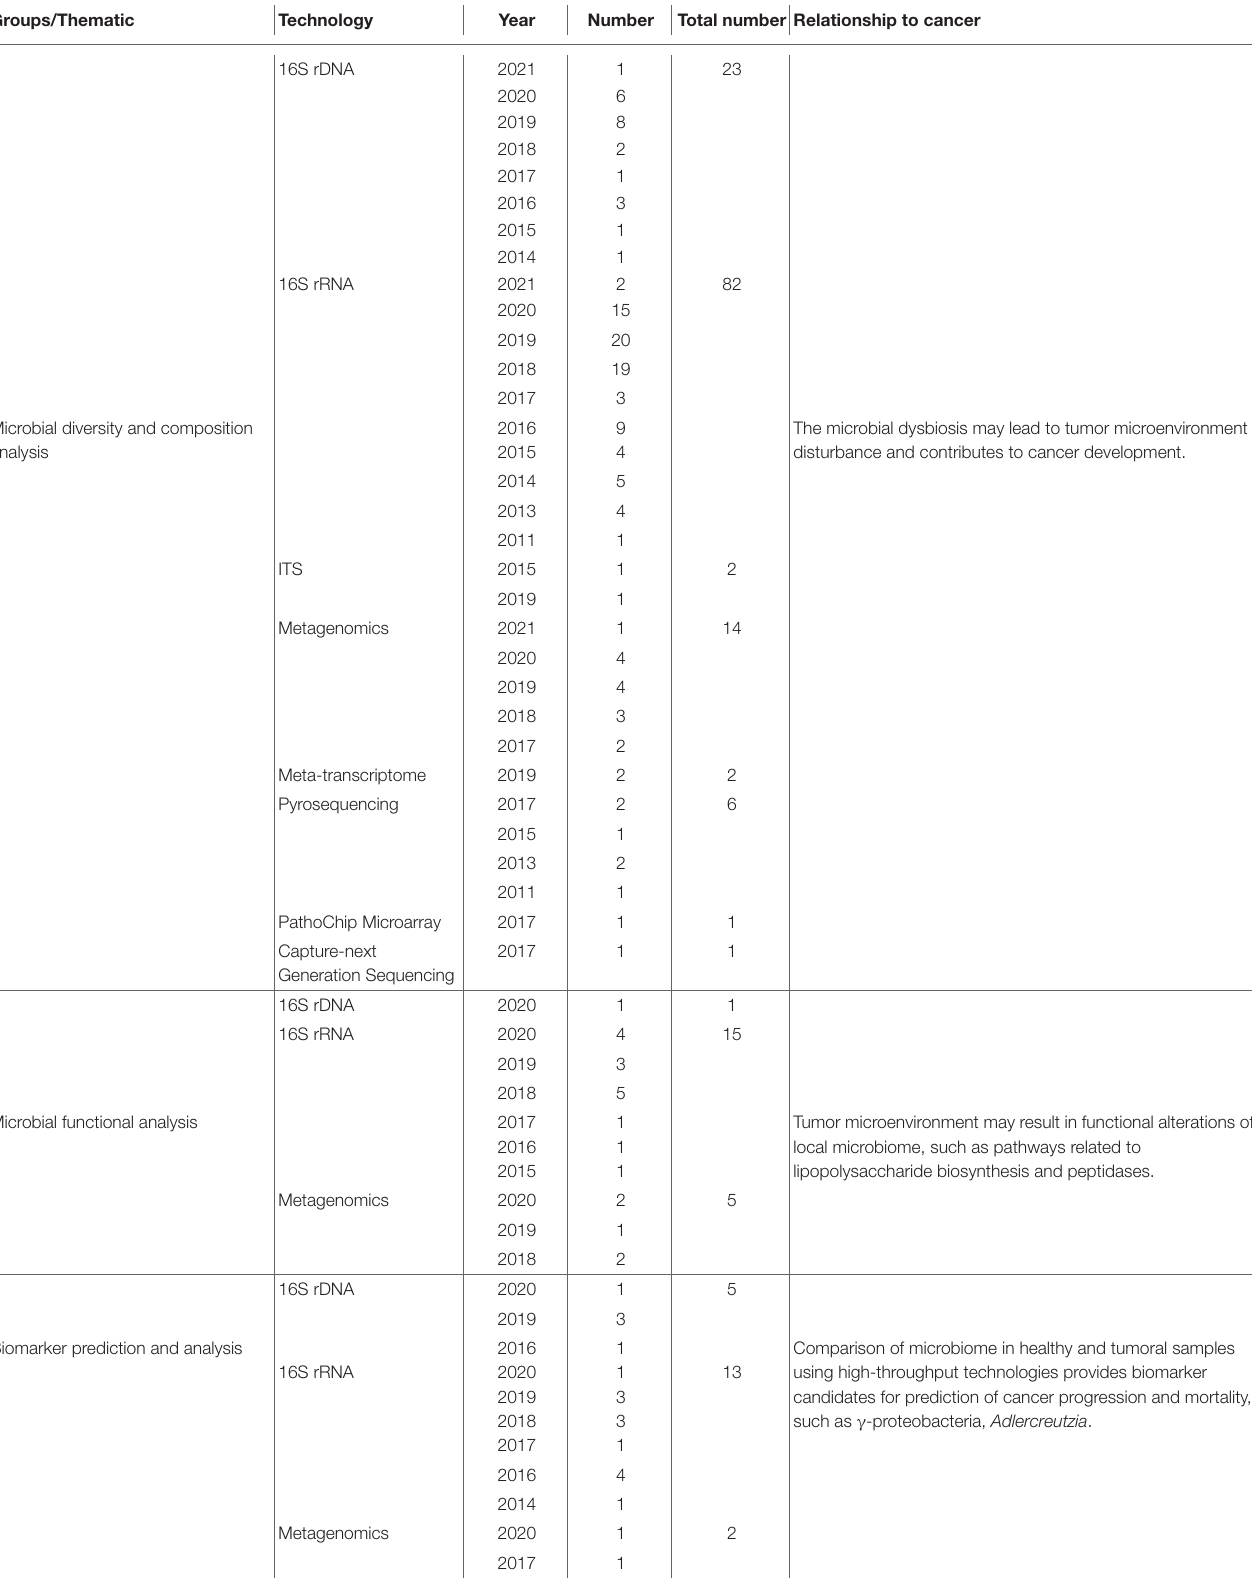
TABLE 2 | Thematic groupings of included